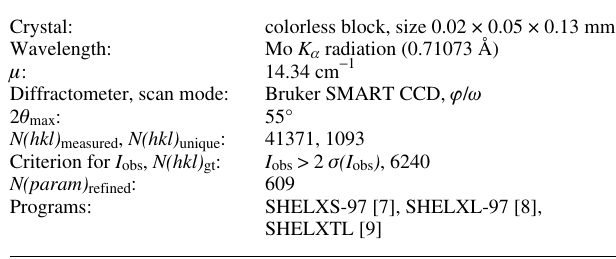
Table 1. Data collection and handling.